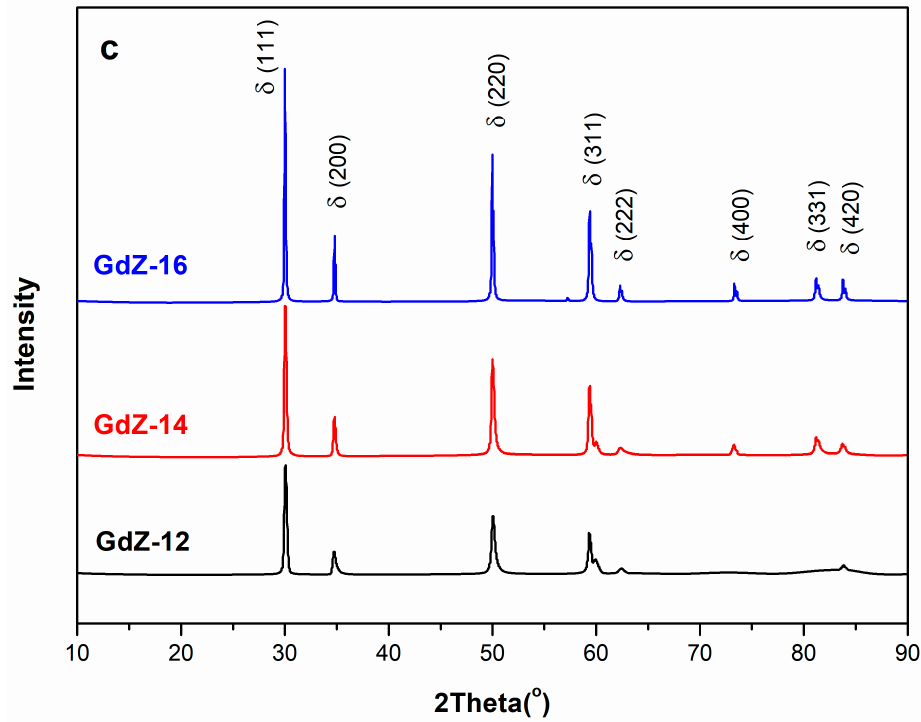
Figure 2. The XRD patterns of GDZ systems for ( a ) x = 1 and 2 mol% monoclinic (M), ( b ) x = 4, 6, 8, 10 mol% tetragonal (T) and ( c ) x = 12, 14, 16 mol% cubic (C) phases samples. Table 2. Observed phases, lattice parameters, c and a ratio, lattice volumes and crystal sizes